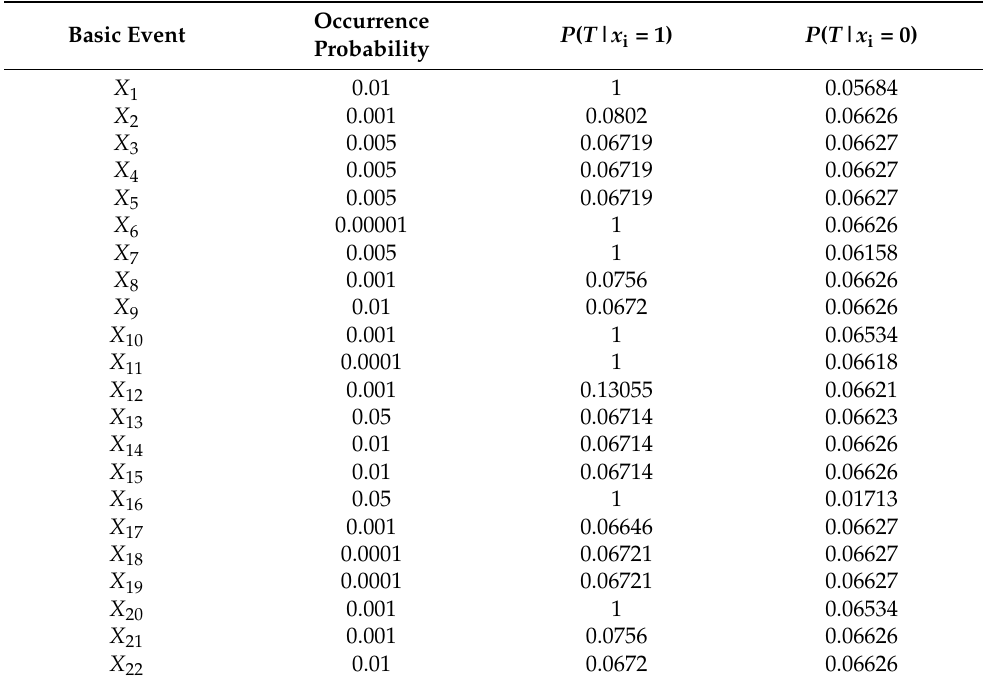
Table 1. Probability of basic events and top event.